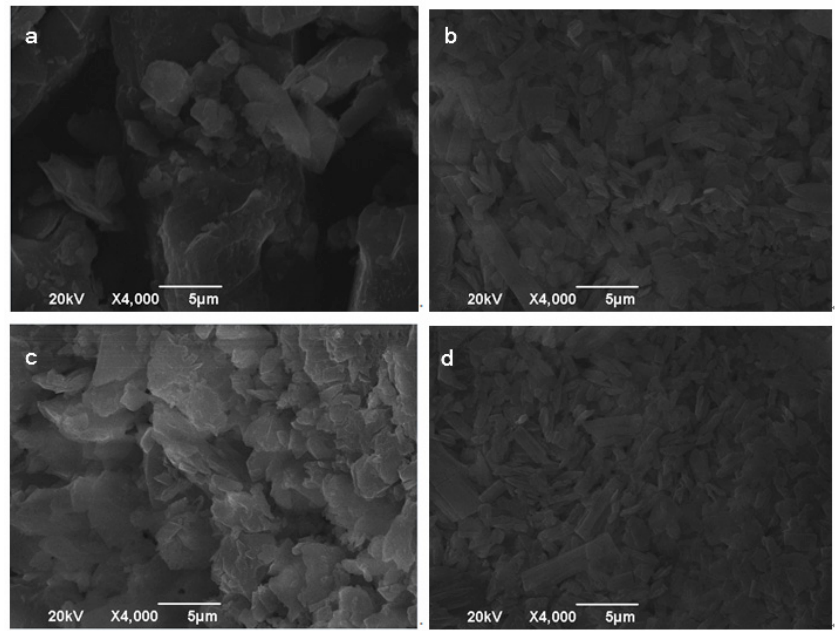
Figure 1. SEM of lycopene ( a ), β -CD ( b ), their physical mixtures ( c ) and inclusion complexes ( d ).